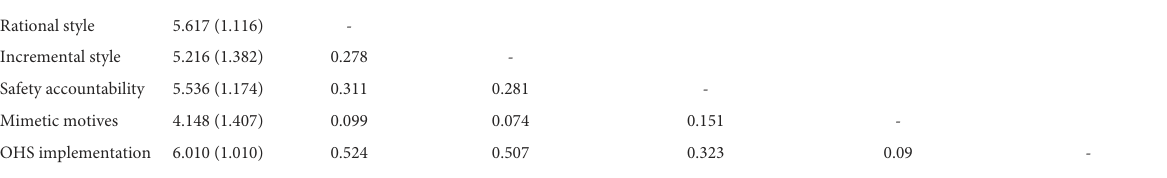
TABLE 3 Measurement model: Discriminant validity (HTMT 0.85